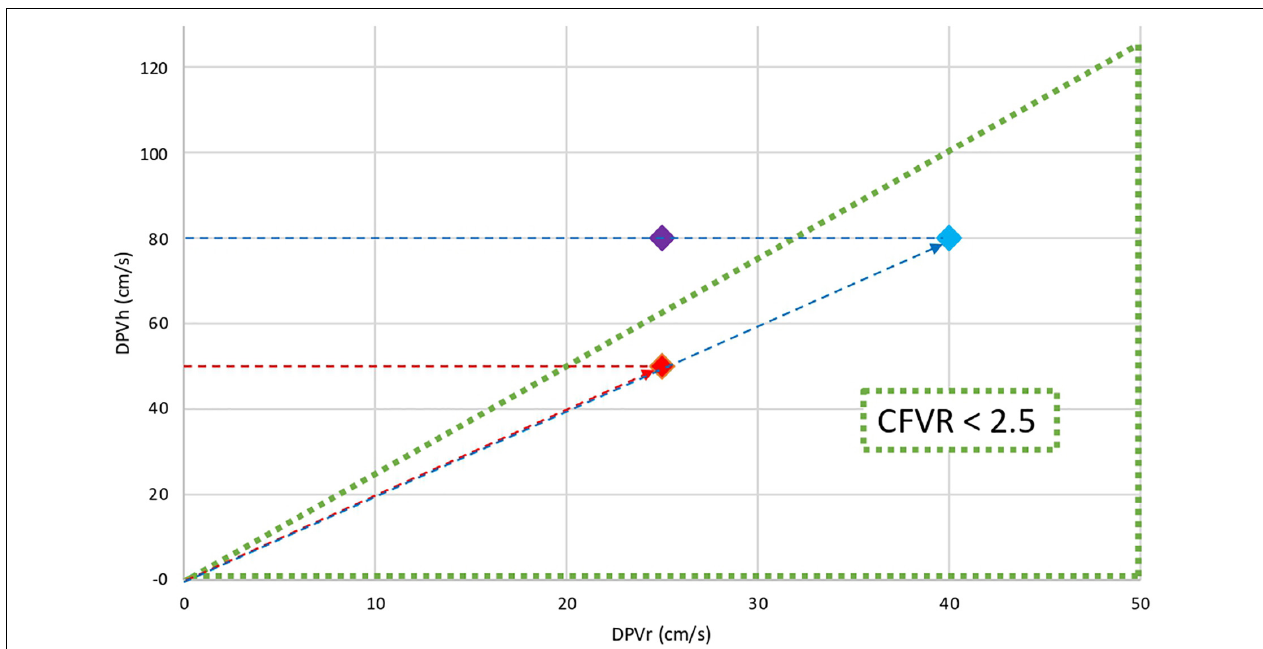
FIGURE 1 | Cartesian and polar coordinates in the flow velocity domain. The triangular area represents coronary microvascular dysfunction (CFVR ≤ 2.5). The graph shows the DPV h (cm/s) versus DPV r (cm/s) for three different patients: Red dot and Blue dot have the same CFVR (2.0) while Purple dot has normal CFVR (3.2). Clearly, the CFVR values for Red and Blue dots are identical, although the flow velocity levels both at rest and during hyperemia are substantially different. This discrepancy indicates that CFVR alone cannot adequately define myocardial perfusion conditions. The difference between various pathophysiological states can be further quantified by calculating their individual distance to the origin, that is, the length of the red dotted line with the arrowhead and the blue dotted line with the arrowhead. This companion, denoted as CCFVR (cm/s), equals the hypotenuse (Red dot CCFVR = 55.9 cm/s; Blue dot: CCFVR = 89.4 cm/s).